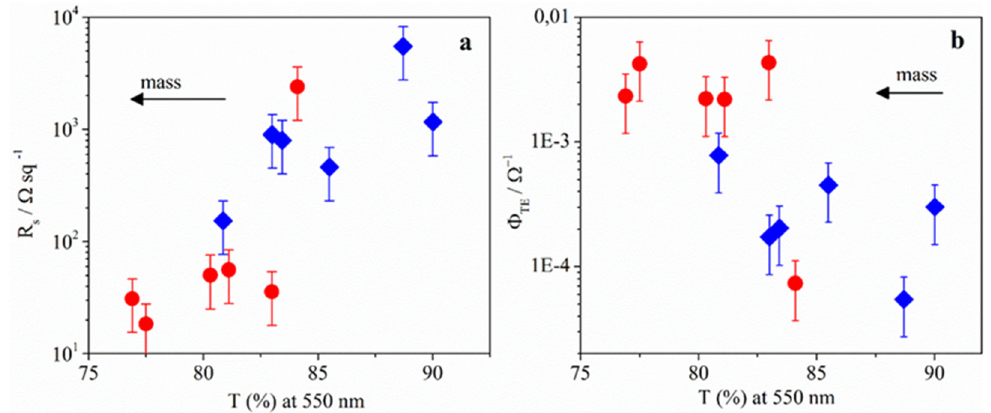
Figure 2. ( a ) Variation of R s and ( b ) the Haacke parameter Φ TE with transmittance for PVP ‐ AgNWs (Diamonds) and C8 ‐ AgNWs (circles). Arrows represent the direction in which the mass of AgNWs deposited onto the substrate increases.